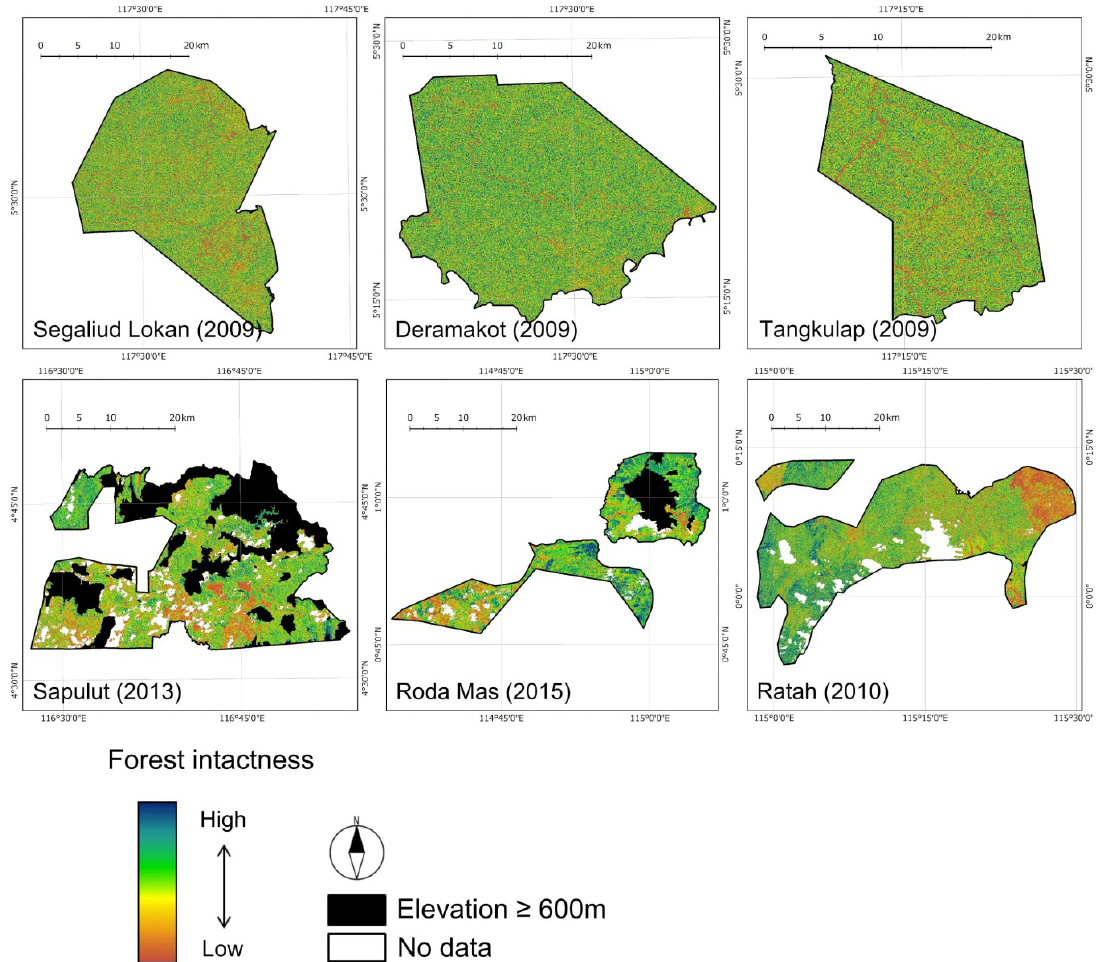
Figure 3. Tree-community composition maps of all FMUs. A color gradation from blue to red indicates a gradient of normalized nMDS axis-1 scores from high to low values as a proxy for canopy tree composition at a genus level.